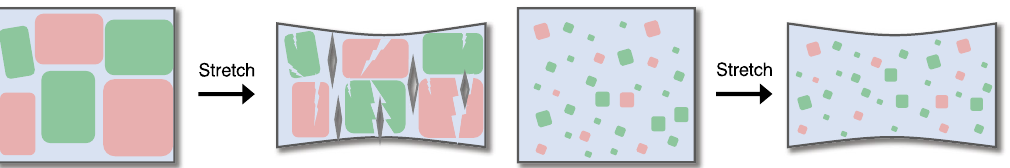
Fig. 3 Comparison of polymer blend and terpolymer fi lms. a Mobilities of the polymer blend fi lms and the terpolymer ones measured from top-contact- bottom-gate transistors given in Fig. 1c. Error bars represent SD. b Crack onset strain of the polymer blends. The blend fi lms showed negligible improvement of stretchability. Error bars represent SD. c Diffraction intensity along Q z direction vs. Q -values of the polymer blend fi lms from GIXD measurements. The blend fi lms showed negligible intensity change. d Schematic of the proposed mechanisms behind different behaviors of the blend and the terpolymer fi lms under